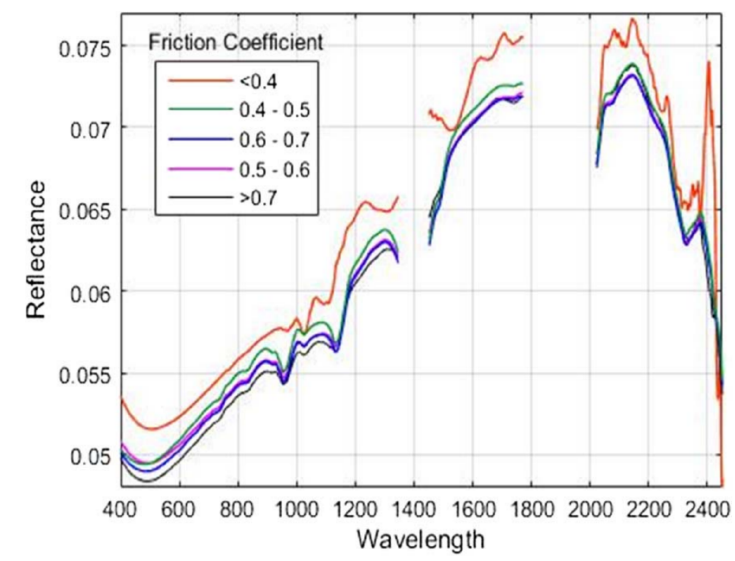
Figure 6. Asphalt spectra with ordered friction coefficient values reproduced from